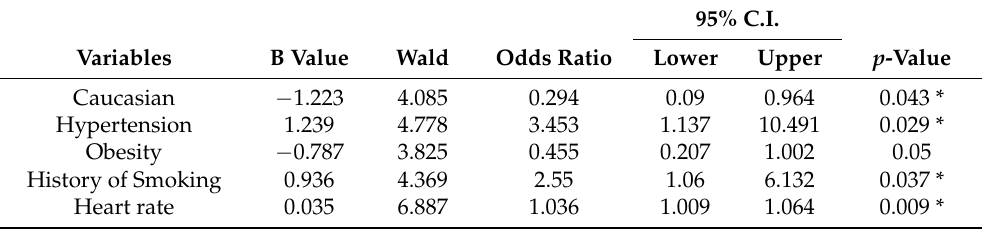
Table 4. Clinical factors associated with an NIHSS score > 7 for ischemic stroke patients with a diastolic blood pressure > 80 mmHg in the telestroke network. Adjusted OR < 1 denotes factors associated with not having an NIHSS score > 7, while OR > 1 denotes factors associated with having an NIHSS score > 7. Hosmer–Lemeshow test ( p = 0.820), Cox and Snell ( R 2 = 0.142). The overall classified percentage of 70.6% was applied to check for the fitness of the logistic regression model. * Indicates statistical significance ( p < 0.05) with a 95% confidence interval. Classification table (overall correctly classified percentage = 70.6%) and area under the ROC curve (AUC = 0.644, 0.568–0.720) were applied to check model